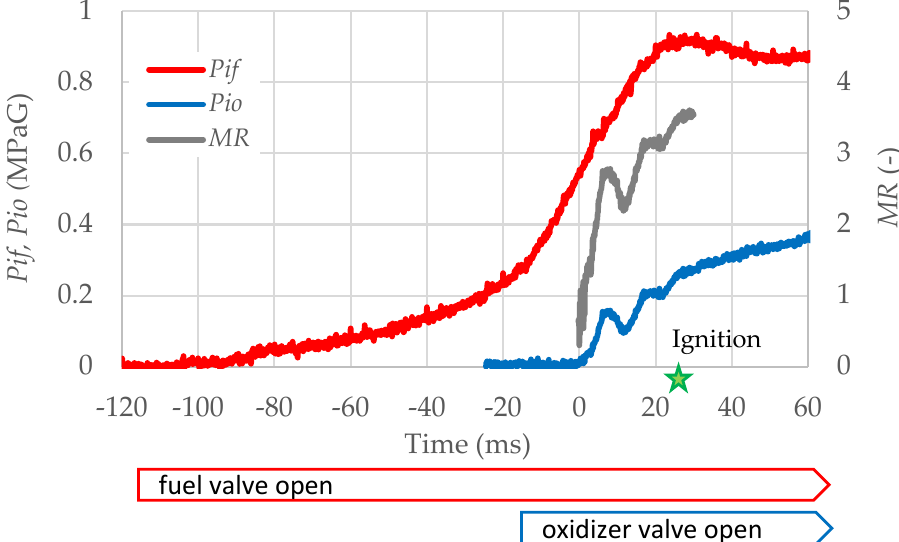
Figure 18. Sample of measured injector pressure and calculated mixture ratio in early phase of in ‐ jection.